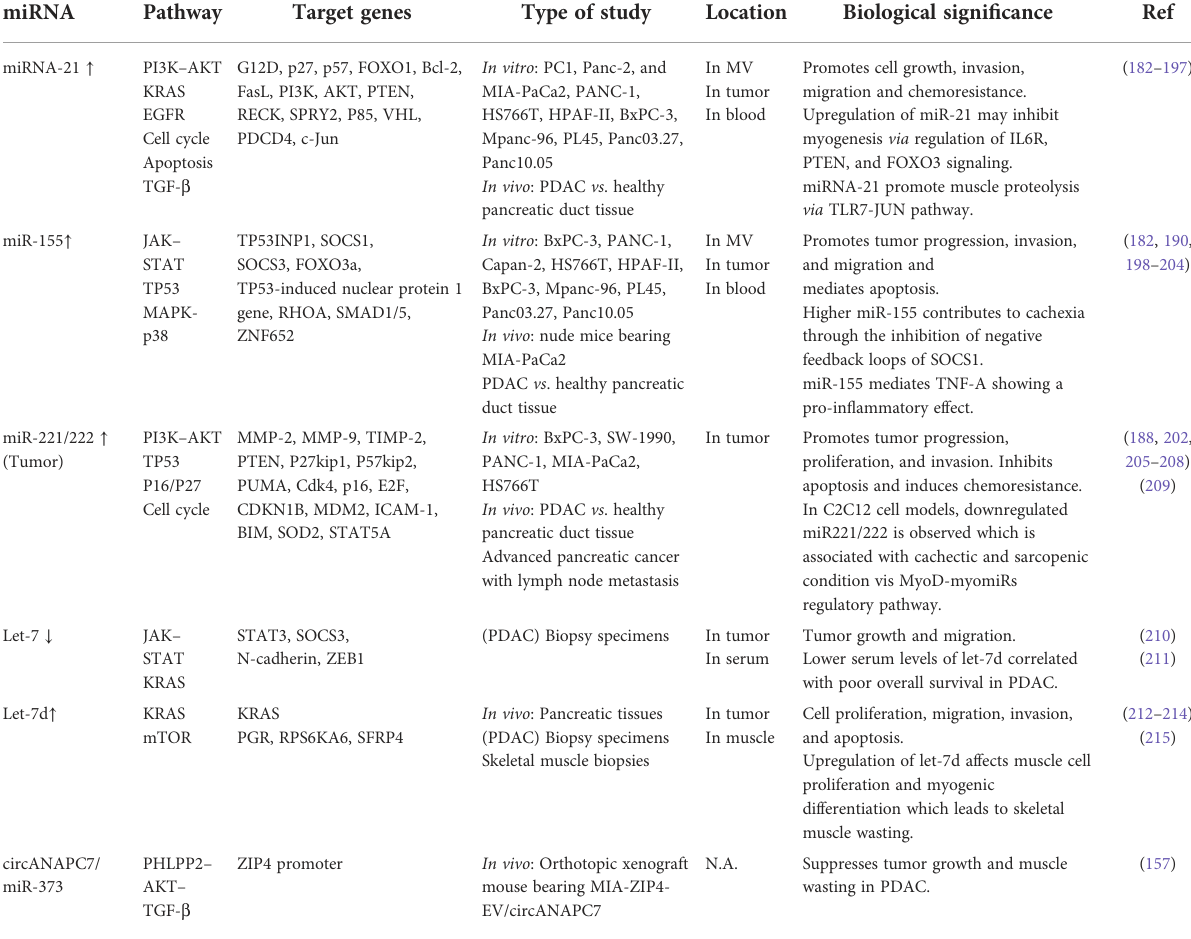
TABLE 6 MicroRNA (miR) expression levels and functions in pancreatic ductal adenocarcinoma (PDAC) and PDAC cachexia.